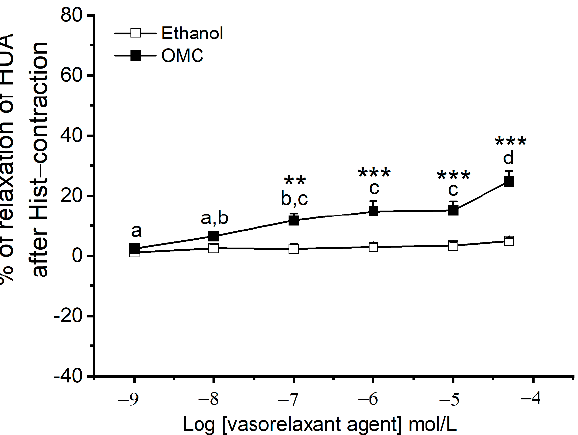
Figure 5. Percentage of relaxation of human umbilical artery (HUA)-rings incubated with octyl- methoxycinnamate (OMC), contracted with histamine (Hist; 1 µ mol/L) and exposed to cumulative concentrations of OMC (0.001–50 µ mol/L). Each point represents the mean and vertical lines represent the S.E.M. * Represents a significant difference when compared with the respective solvent control: ** ( p < 0.01) and *** ( p < 0.001); and the different letters represent significant differences between OMC concentrations ( p < 0.05); two-way ANOVA method followed by Holm–Sidak post-hoc tests 3.5. Long-Term Effects of OMC on Vascular Responses of Human Arteries to Agonists and Antagonists of Different Hist Receptors